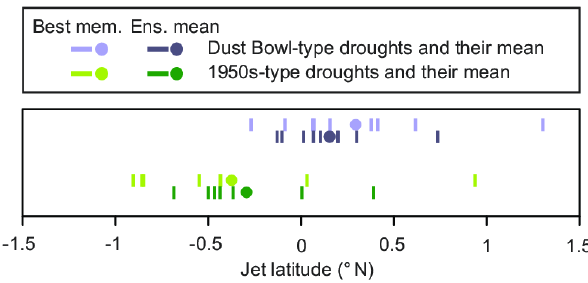
Figure 3. Changes in the position of the subtropical jet over North America for Dust Bowl-type droughts (purple) and 1950s- type droughts (green). Anomalies are relative to the preceding and following 5-year period of the drought. Lines indicate individual drought periods, the circles indicates the drought-type means.